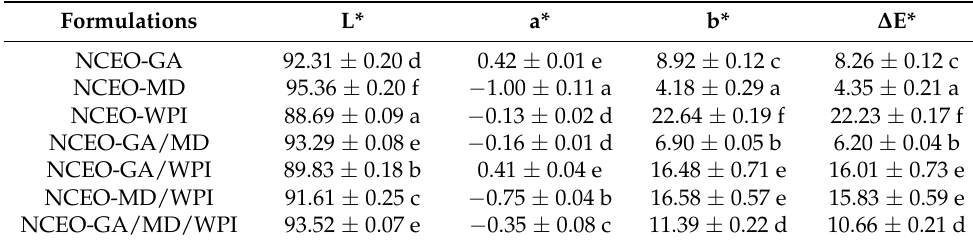
Table 7. Color parameters of CEO